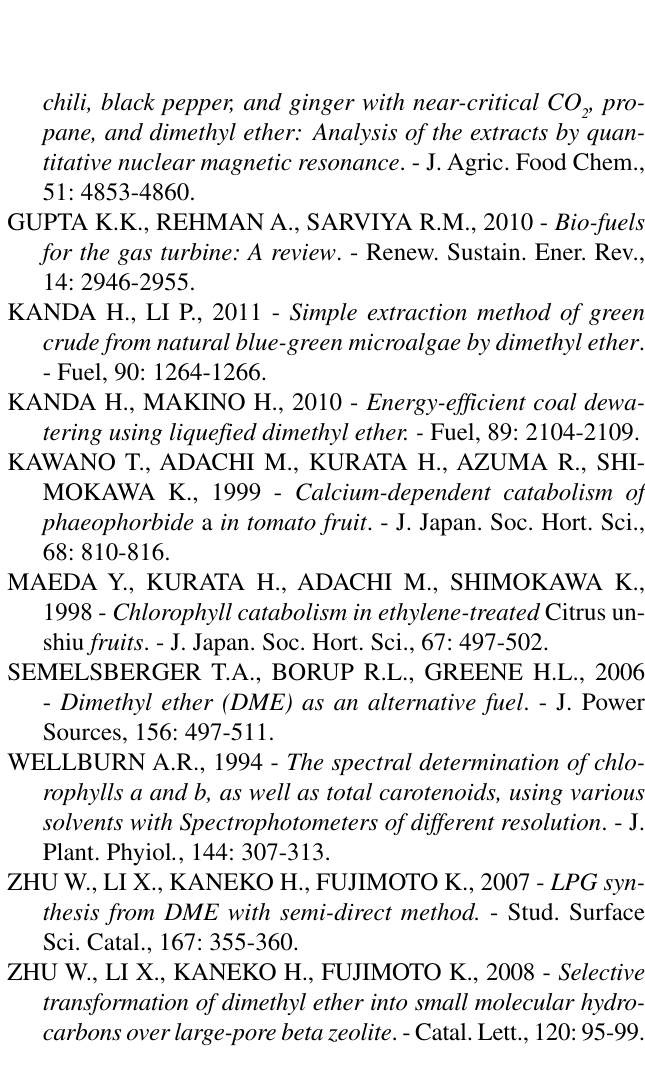
Fig. 7 - Detection of α - and β -carotenes with HPLC. HPLC chromato- grams show the peaks of carotenoids extracted with DME from squash peel, squash pericarp, spinach leaves and carrot roots. Pigments eluted from Inertsil ODS-80A column were detected by monitoring the changes in absorption at 455 nm.